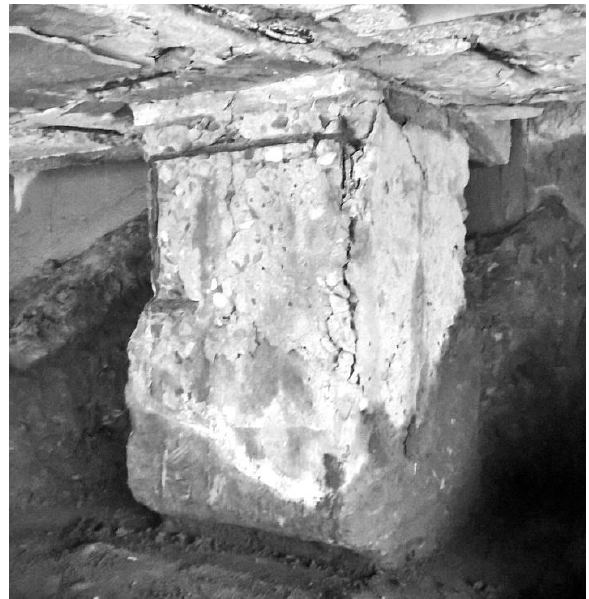
Figure 7. Deterioration and cracks on the concrete pendulum bearing.